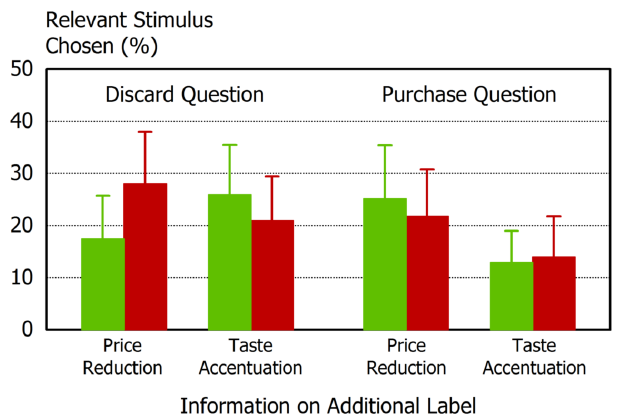
Figure 4. Interaction of label color (green, red) and label information (price, taste) in trials with the discard question, and in trials with the purchase question; error bars represent 95% confidence intervals. Redrawn after Helmert et al. [29], Have an eye on the buckled cucumber: An eye tracking study on visually suboptimal foods. Food Quality and Preference 60 (2017) 40–47, with permission from Elsevier.